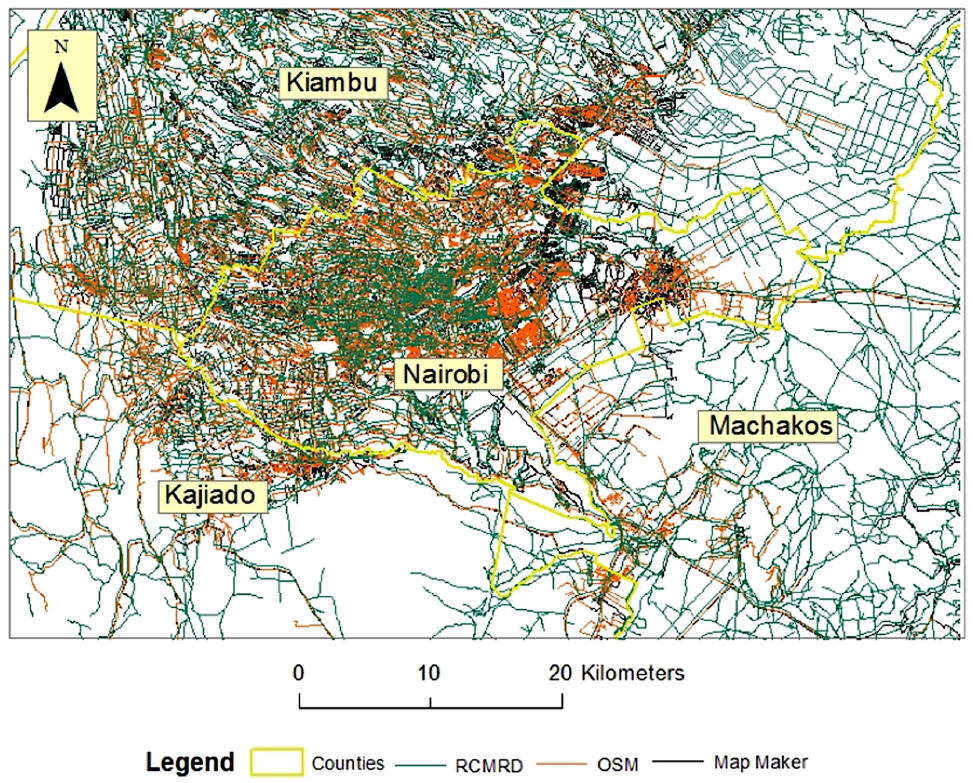
Figure 3. Roads in Nairobi and surrounding areas.